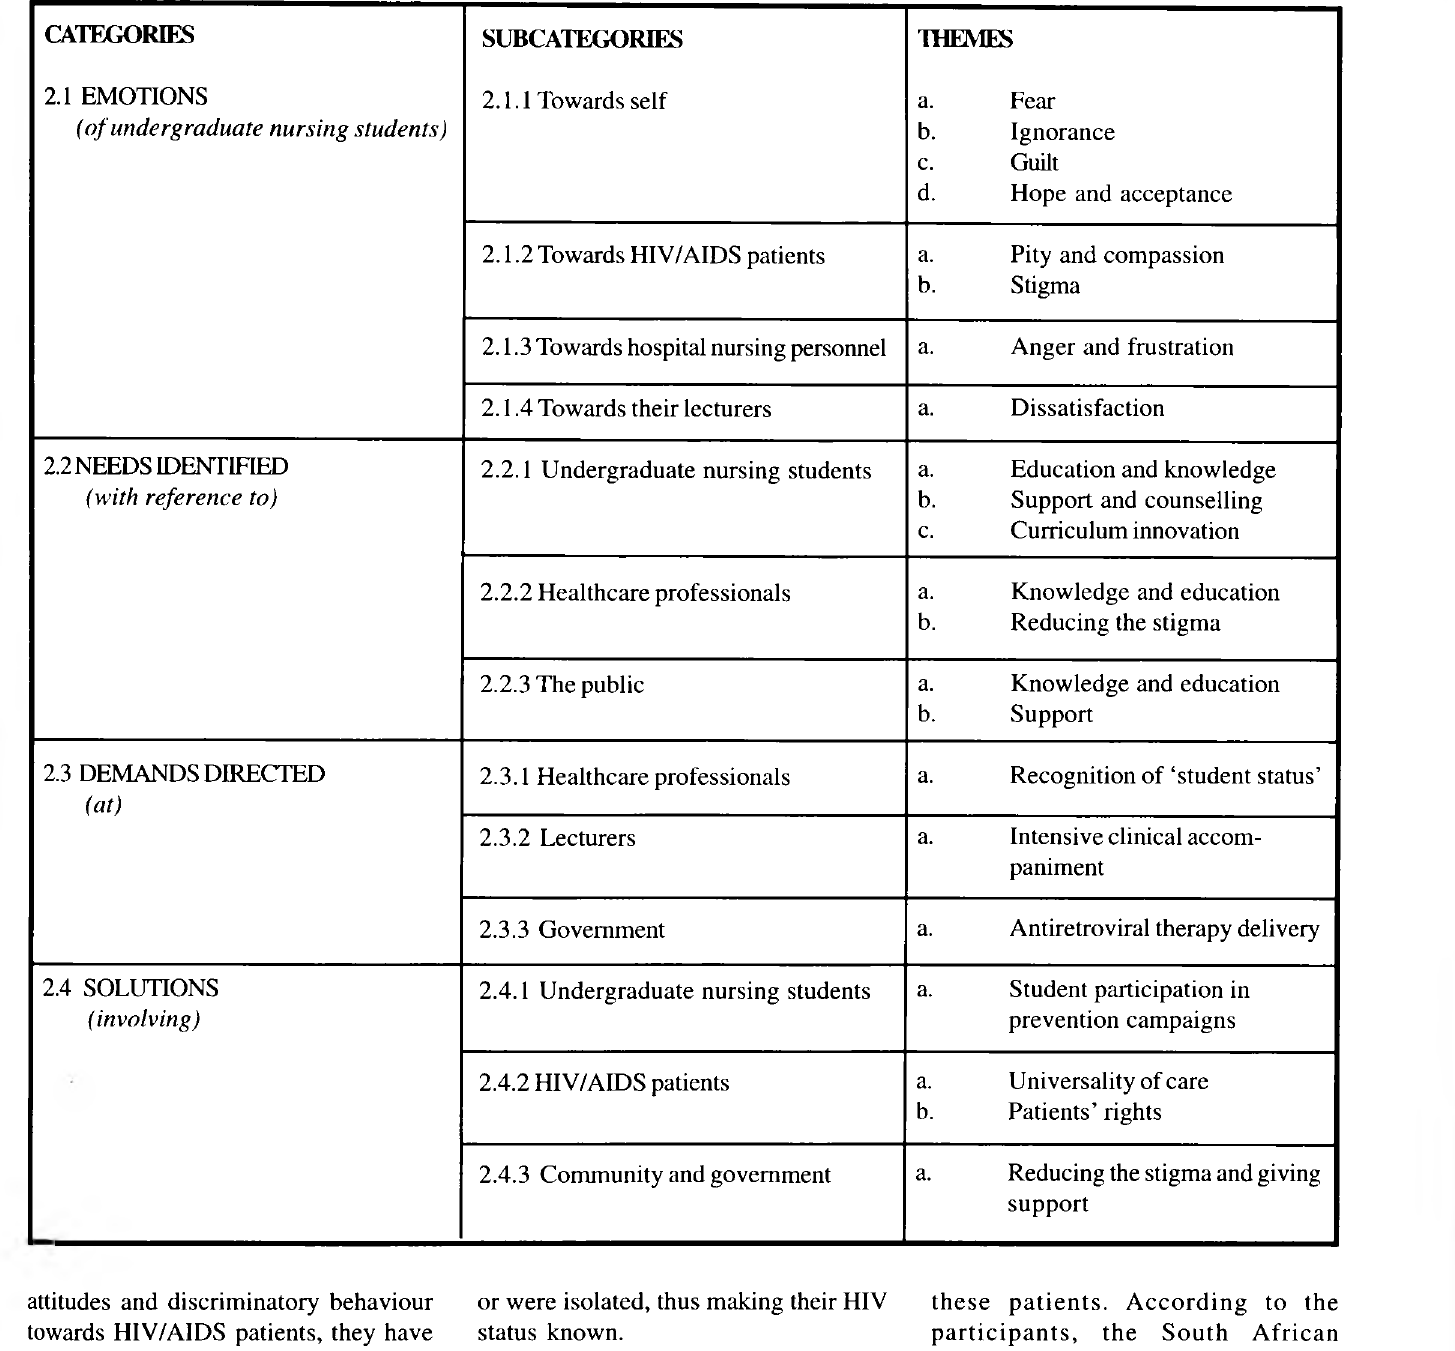
Table 2: Summary of categories, subcategories and themes